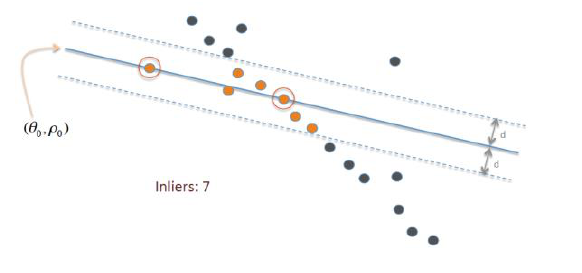
Figure 3. RANSAC: Inliers and Outliers (URL: